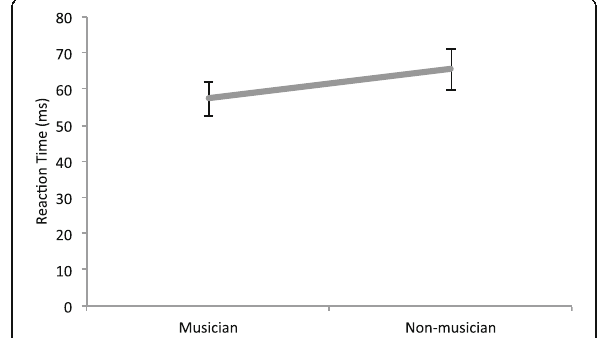
Fig. 4 Musician status in the flanker task. Musicians outperformed non-musicians on null, neutral, congruent, and incongruent condi- tions. Error bars represent